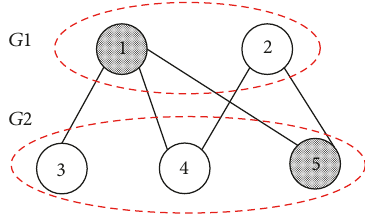
Figure 1: The bipartite topology of the heterogeneous MASs.